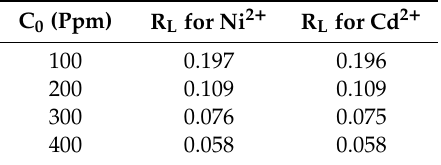
Table 6. Separation factors (R L ) at each adsorbate concentration.